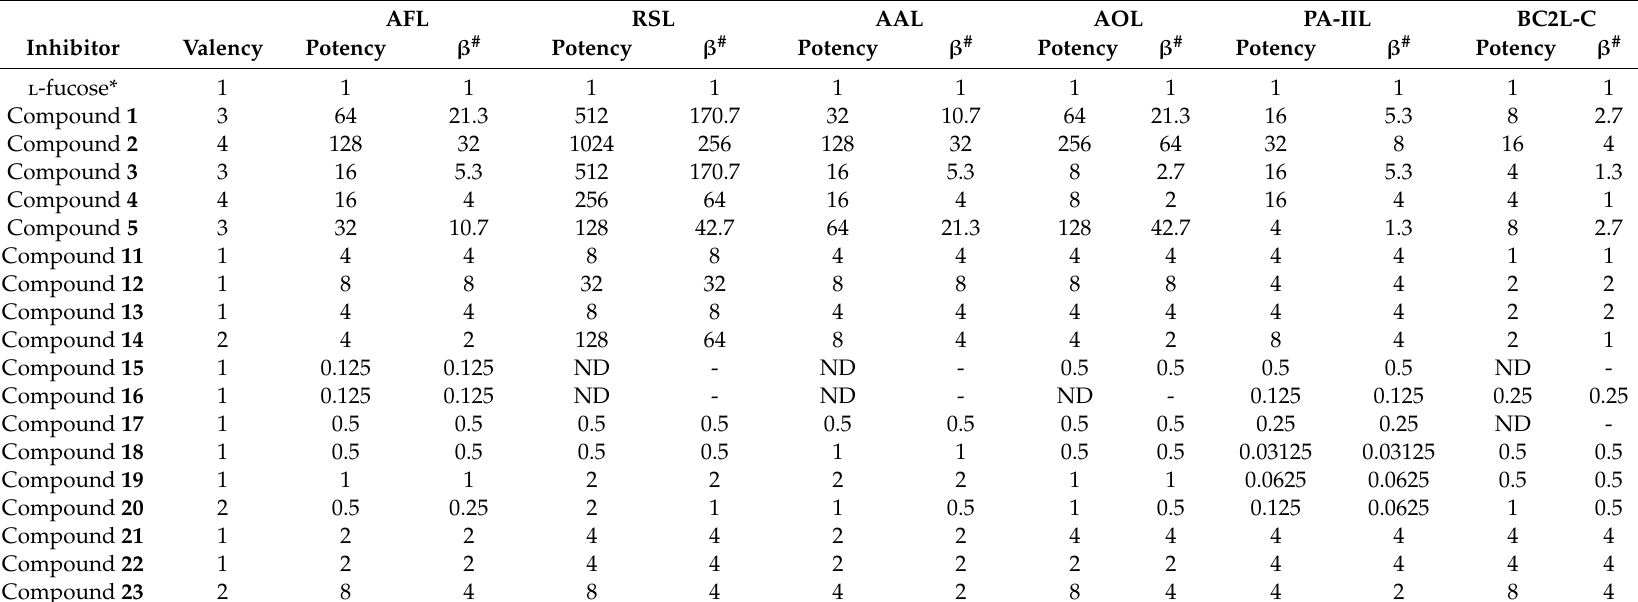
Table 1. Potencies of tested inhibitors against fucose-specific lectins determined by a hemagglutination inhibition